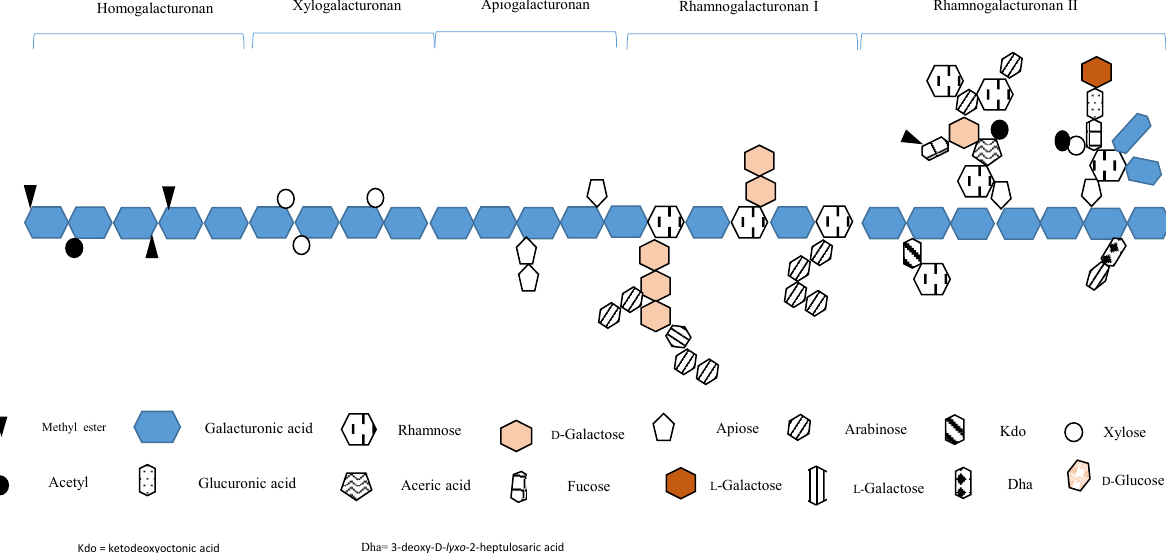
Figure 2. Substitution of galacturonic acid [17]. 2.1.1. Homogalacturonan Partially C-6 carboxylated and O-2 or O-3 acetylated HGs are the most abundant forms in pectin [2,18] as they represent between 57% to 70% of them [19]. The methyl esterification of the homogalacturonan regions partly determines the extent of industrial applications of pectins and their capacity for interaction [20]. This methyl esterification corresponds to the degree of methylation (DM) as a percentage. HGs form the smooth zone of pectins. 2.1.2. Rhamnogalacturonan I RG-I (Figure 1) is a region that makes up 7–14% of the pectin and is made up of al- ternating Gal p A and Rha. Interruption of the galacturonan backbone by L -Rha, forming a (1,4)- α - D -galacturonic acid-(1,2)- α - L -rhamnose repeating unit, forms the backbone of rhamnogalacturonan I [21]. Twenty to eighty percent of L -Rha present in this region is substituted by Gal p or Ara at the C-4 position. The Gal p A residues from this region can also be methylated or acetylated but at a lower frequency compared with homogalac- turonan regions [14,19]. In some plants (beetroot, spinach, etc.), the side chains can be substituted by phenolic acids (ferulic or coumaric acids) esterifying the alcohol functions in position 6 of galactose residues or in position 2 of arabinoses [22].